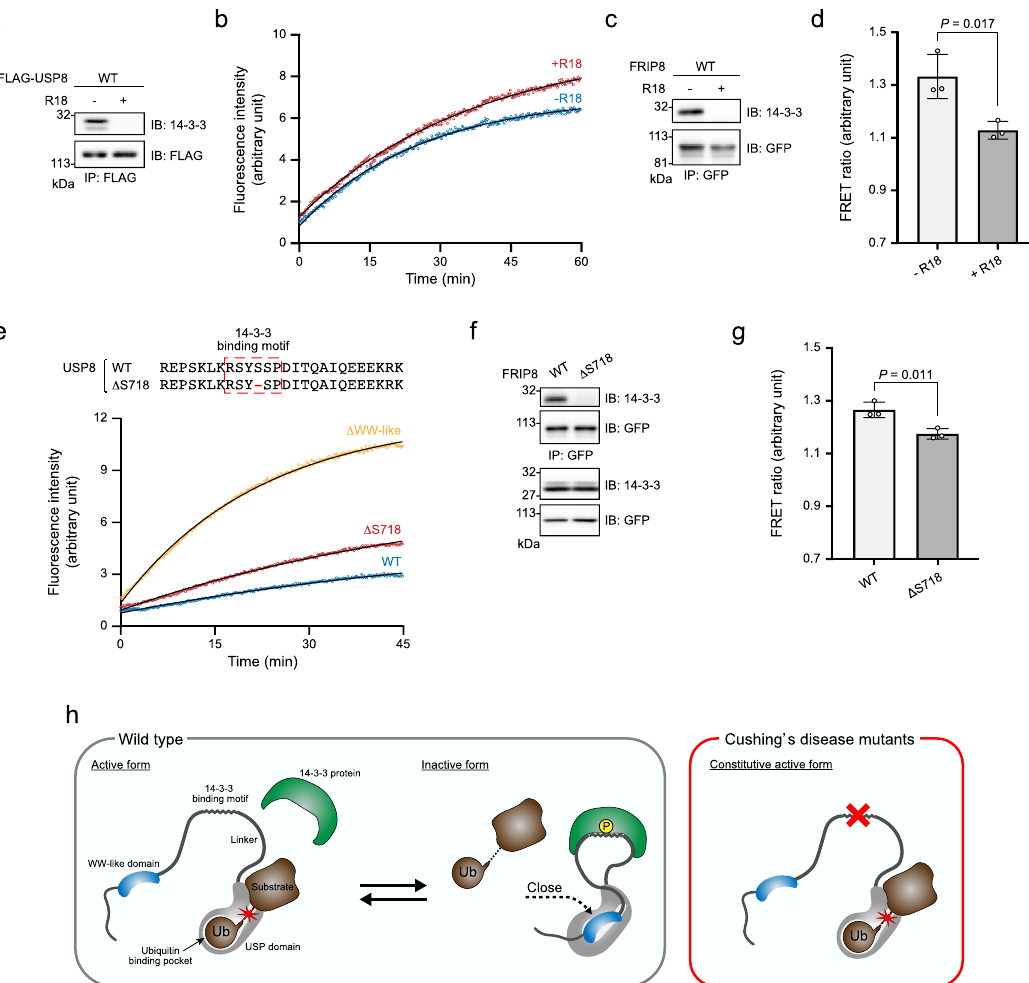
Fig. 5 Effects of 14-3-3 on the interaction between the WW-like and USP domains. a Effects of R18 on co-immunoprecipitation of USP8 with 14-3-3. HEK293 cells expressing FLAG-tagged USP8 were lysed. The lysate was incubated with 100 μ M R18 before being subjected to immunoprecipitation and immunoblotting. b Effects of R18 on USP8 deubiquitinating activity. The lysates of HEK293 cells expressing FLAG-tagged USP8 were incubated with 100 μ M R18 before they were subjected to an in vitro deubiquitination assay similar to that described in Fig. 2e. c , d Effects of R18 on FRIP8. HEK293 cells expressing FRIP8 and 14-3-3 ε were lysed. The lysate was incubated with 100 μ M R18 and then subjected to immunoprecipitation and subsequently immunoblotting ( c ). Samples were analysed using similar methods to those described in Fig. 3g ( d ). The graph shows the means± standard deviations of three independent experiments. Statistical signi fi cance was determined using Student ’ s t -test. e Deubiquitination activities of USP8s with Cushing ’ s disease-associated mutations. The amino acid sequences of the mutants are shown in the top panel. The lysates of HEK293 cells expressing USP8 mutants were subjected to immunoprecipitation; the deubiquitinating activities in immunoprecipitates were then analysed using methods similar to those described in Fig. 2e. f , g Effects of Cushing ’ s disease-associated mutations on FRIP8. HEK293 cells expressing FRIP8 mutants were lysed and subjected to immunoprecipitation. Samples were then analysed using immunoblotting ( f ) and a FRET assay ( g ). The graph shows the means± standard deviations of three independent experiments. Statistical signi fi cance was determined using Student ’ s t -test. h Working hypothesis of the autoinhibitory mechanism of USP8 and its impairment in Cushing ’ s disease